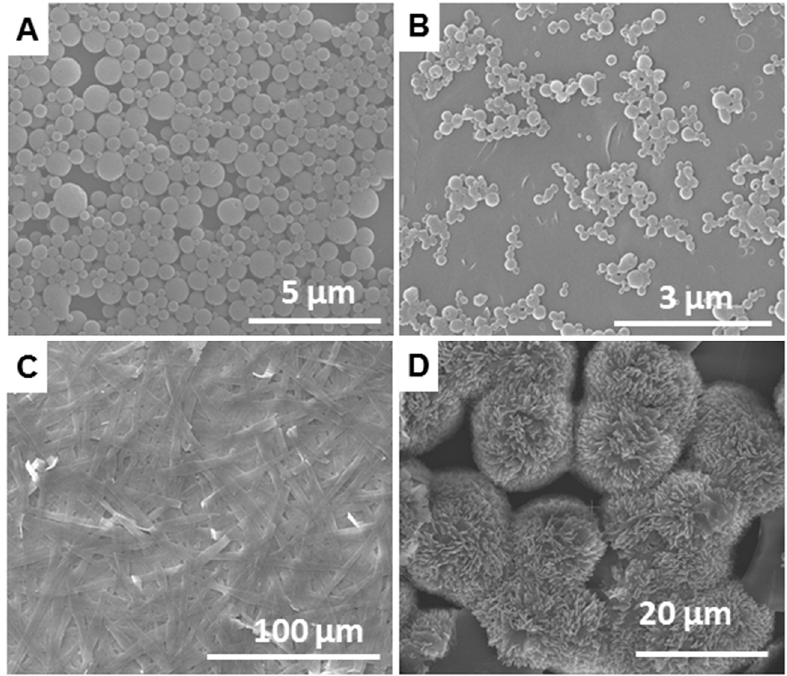
Figure 4. FE-SEM images of aggregates formed from ( A ) TPE-Pi , ( B ) TPE-Az , ( C ) TPE-Su and ( D ) TPE-Se in THF/water with water fraction of 80%.